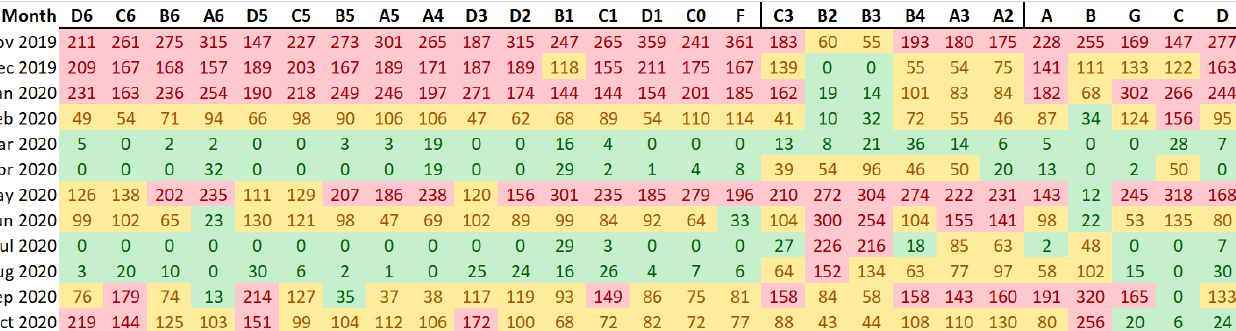
Figure 9. Number of observations outside the security limits for each data-logger (in columns) and each month (in rows). Such limits were determined by applying the standard EN 15757:2010 to each data-logger individually. Columns were sorted conveniently according to the three microclimates identified by PCA-clustering (i.e., the three blocks of columns correspond to the three color codes used for data-loggers in Figure 1). For each column, the highest three values are highlighted in red, and the three lowest values, in green.